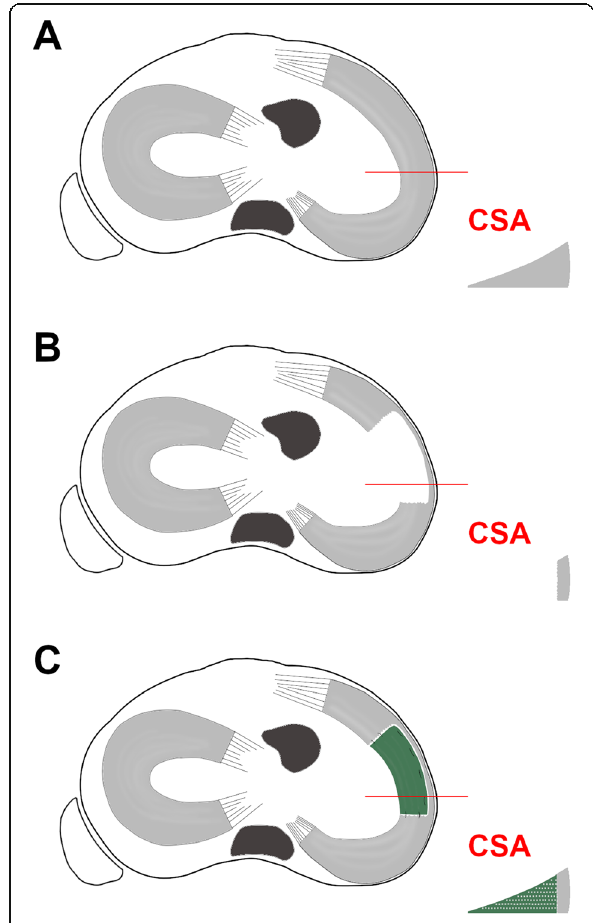
Fig. 3 Schematic illustration of scaffold-based partial medial meniscal replacement. Proximal view of the tibial plateau and the respective cross-sectional area (CSA) of the medial meniscus at the level of the red line for the following conditions, a) Intact; b) After extensive partial medial meniscectomy; c) After scaffold-based partial medial meniscal replacement. Note the framework of the meniscal